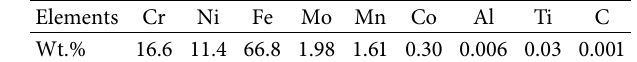
Table 1: Elemental composition and weight% of tested SS substrates. Elements Cr Ni Fe Mo Mn Co Al Ti C